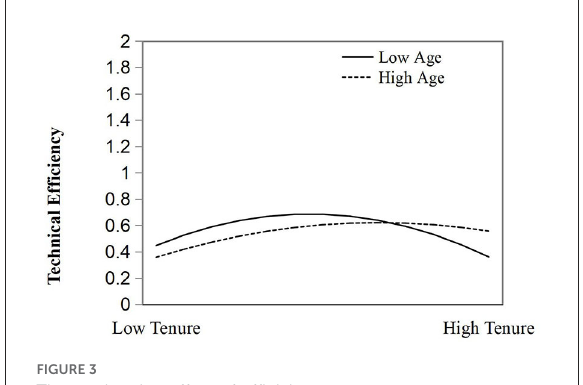
FIGURE3 The moderating effect of official age.